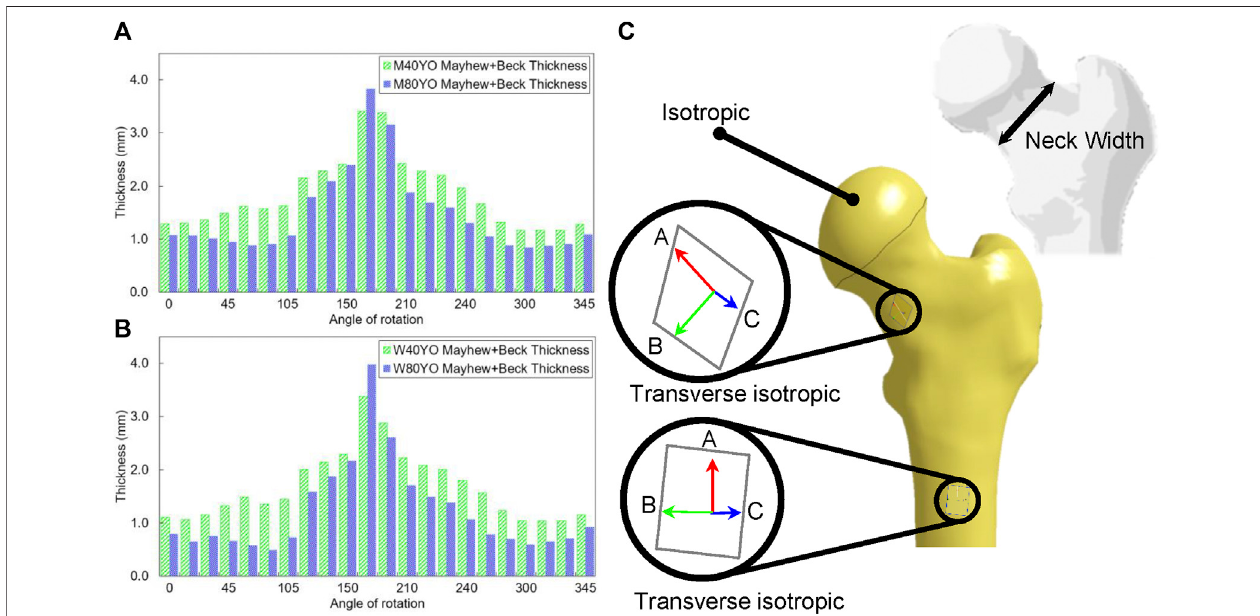
FIGURE 1 | The cortical thickness changes for (A) men and (B) women in 40 and 80 years old was estimated using the combination of Beck et al. (2000) and Mayhewetal.(2005),(Angleofrotationwasassumedinsuchawaythattheposteriorofthefemoralneckcorrespondsto270 ° ), (C) transverseplaneoftheshaftandneck (Plane ’ s normal is in red), the femoral head was assumed to be